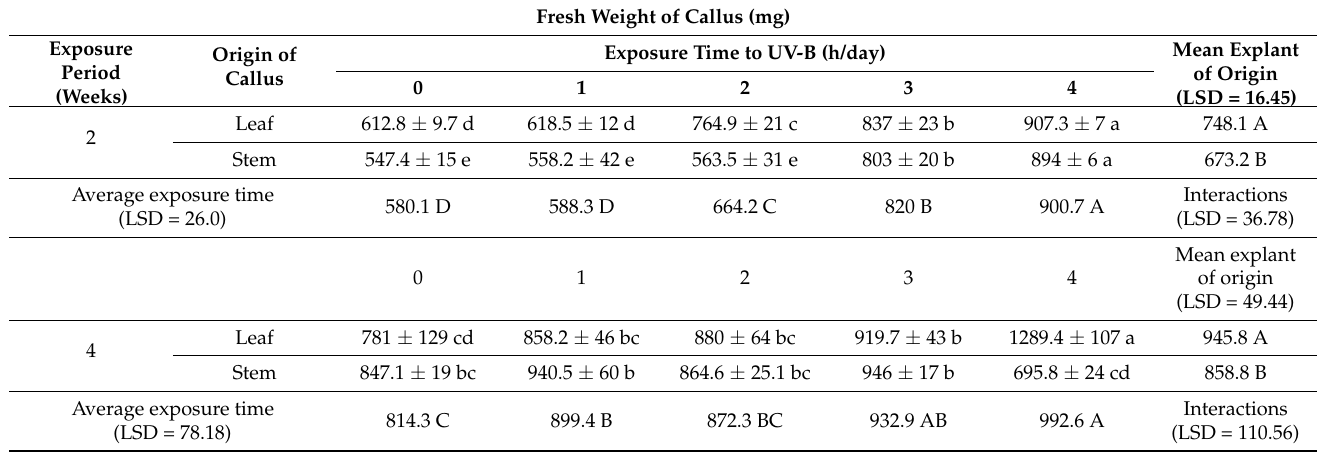
Table 1. Effect of time of exposure to UV-B radiation and origin explant on the fresh weight of the callus